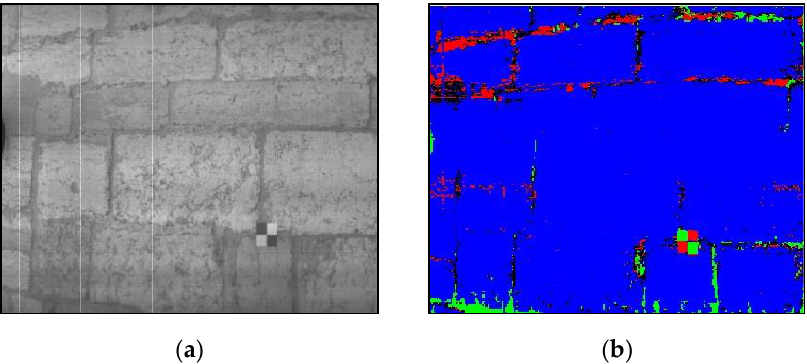
Figure 20. ( a ) Hyperspectral image; ( b ) Material classification obtained with a neural network (Blue = white Lioz limestone).